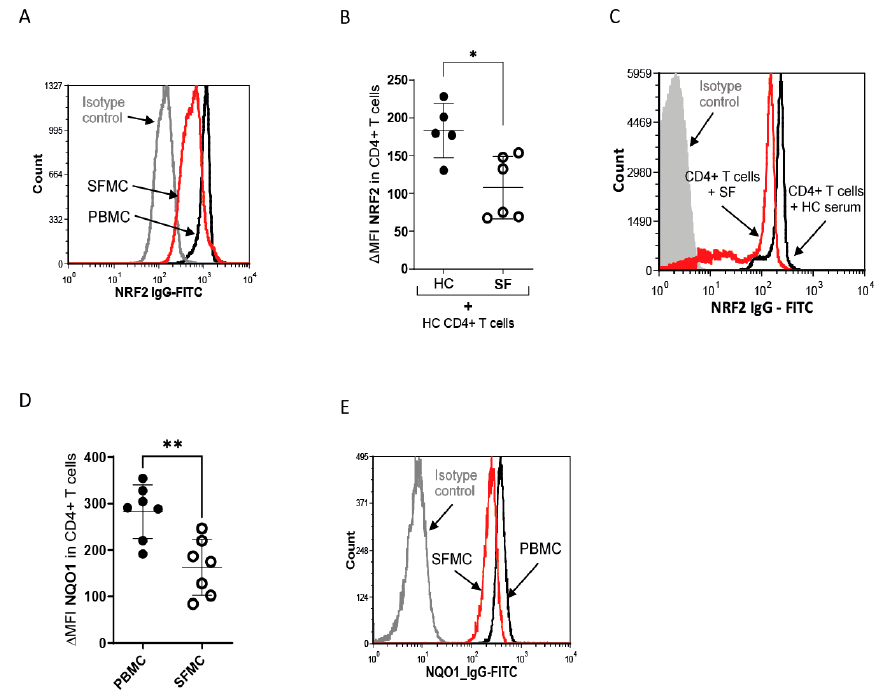
Figure 2. NRF2 protein expression is reduced in SF T cells. ( A ) Representative histogram of NRF2 in SFMCs (red) and PBMCS (black) MFI and IgG isotype MFI (grey). ( B ) Statistical analysis of Δ MFI of NRF2 in HC CD4+ T cells after incubation with 10% HC (N = 5 for donors and two individual experiments) serum or SF (N = 6 for donors and two individual experiments) for 18 h. ∆ MFI was calculated as MFI(NRF2)-MFI (IgG) and a two-tailed unpaired t -test was performed. ( C ) Representative histogram of NRF2 in HC CD4+ T cells after incubation with SF serum (red) and HC serum (black). ( D ) Statistical analysis of MFI of NQO1 expression in CD4 + PBMCs (N = 7 for donors and 6 individual experiments) and SFMCs (N = 7 for donors and six individual experiments); ∆ MFI was calculated as MFI(NQO1)-MFI (IgG) and a two-tailed unpaired t -test was performed. ( E ) Representative histogram of NQO1 in SFMCs (red) and PBMCS (black) MFI and IgG isotype MFI (grey). Stastical significance represented as * p < 0.05, ** p <